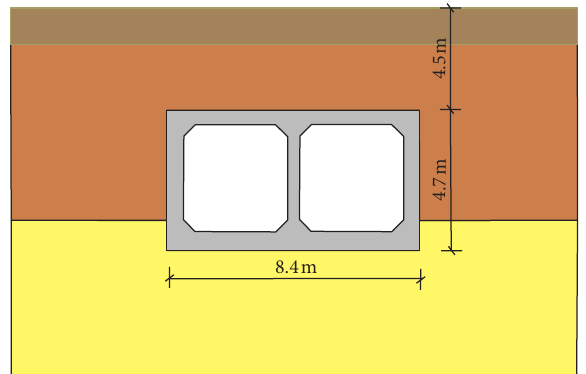
Figure 12: Schematic diagram of utility tunnel structure and burial depth. Table 1: Comparison of results for theoretical analysis and model test.